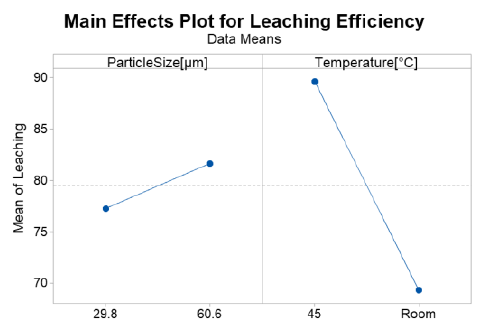
Figure 5. The e ff ect of particle size and temperature on leaching e ffi ciency of copper concentrate. Figure 5. The effect of particle size and temperature on leaching efficiency of copper concentrate.